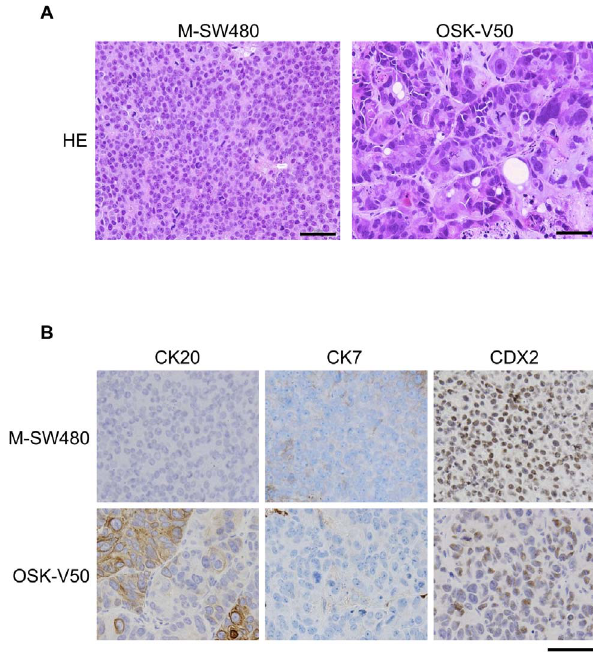
Figure 6. The histology of the xenografts derived from M- SW480 and OSK-V50 cells. (A) Hematoxylin and eosin staining (HE). The tumors derived from M-SW480 cells predominantly consisted of homogeneous cells. On the other hand, the tumors derived from OSK- V50 cells showed glandular structures. (B) Immunohistochemical analysis. The tumors derived from M-SW480 cells were negative for CK20 and CK7. The tumors derived from OSK-V50 cells were partially positive for CK20 and negative for CK7. Tumors derived from both M- SW480 and OSK-V50 cells were positive for CDX2, but CDX2-negative cells were obviously seen in the tumors of OSK-V50 cells. Scale bars: 50 m m.